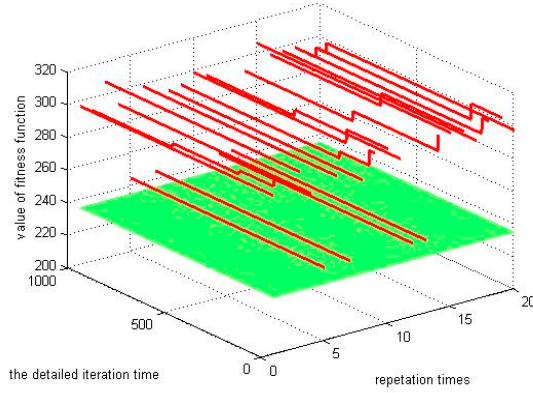
Figure 17. The detailed fitness function values of 1000 iterations with 20 repetitions of the modified CS.